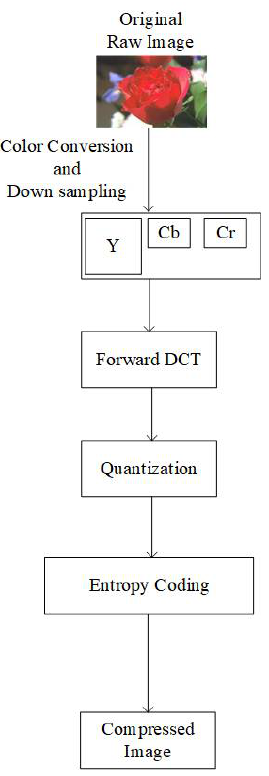
Figure 1. Overview of the conventional JPEG encoder .